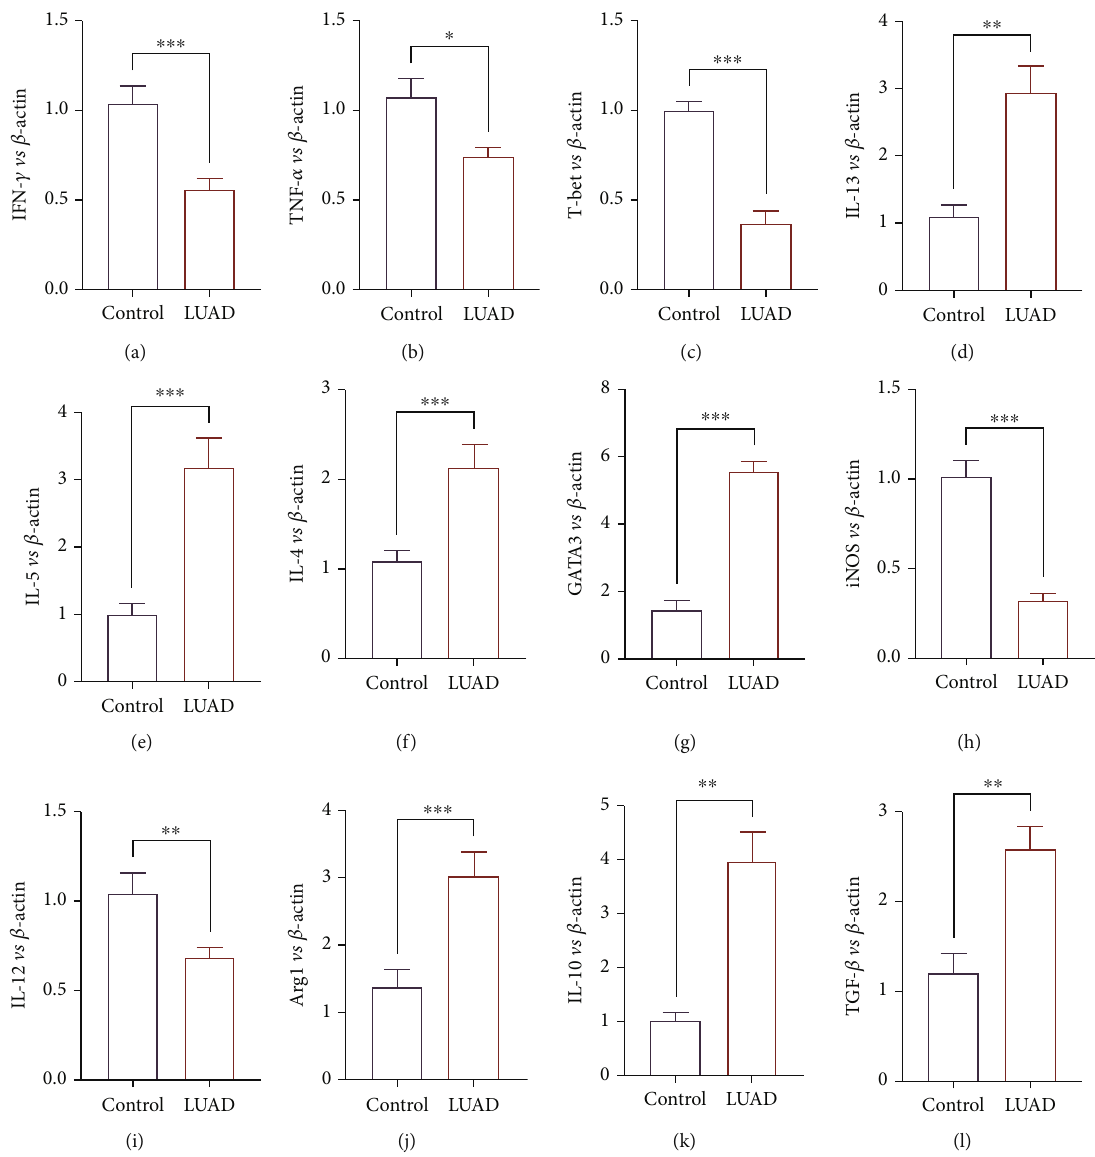
Figure 5: The PBMC levels of ILC-associated and monocytes-associated cytokines in the study population. qRT-PCR analysis of IFN- γ (a), TNF- α (b), T-bet (c), IL-13 (d), IL-5 (e), IL-4 (f), GATA3 (g), iNOS (h), IL-12 (i), Arg1 (j), IL-10 (k), and TFG- β (l) mRNA levels in PBMC from patients and healthy controls. Data shown were represented as mean ± SD (all samples were measured in triplicate). ∗∗∗ P < 0 : 001 , ∗∗ P < 0 : 01 , and ∗ P < 0 : 05